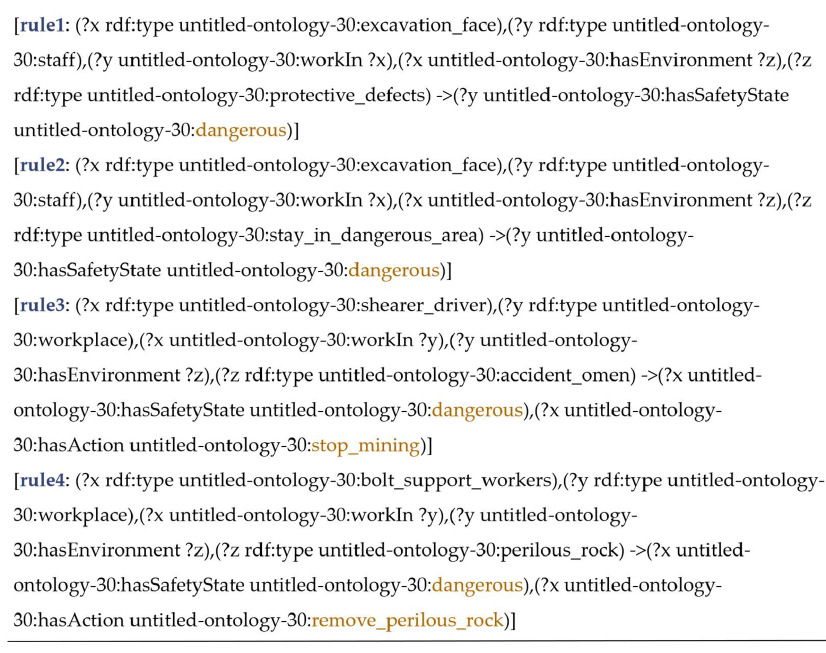
Figure 8. The formalization of the screened safety regulations.